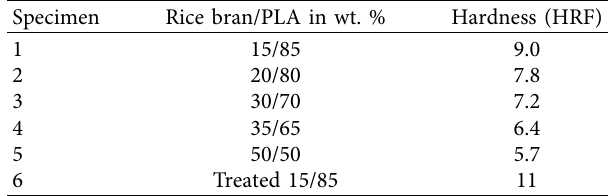
Table 2: Hardness results of rice bran PLA composite. Specimen Rice bran/PLA in wt. %